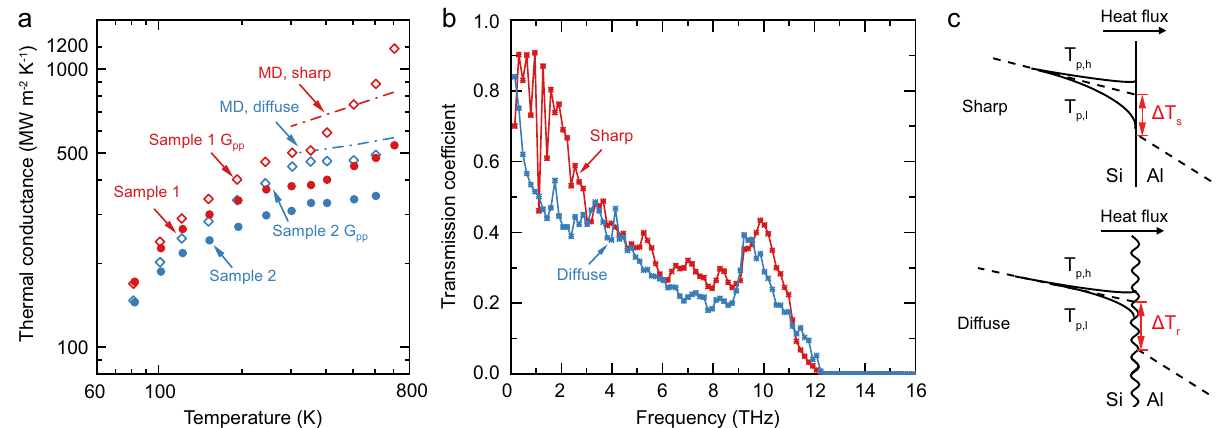
Fig. 3 | Phonon transport behavior across Al/Si interface computed by mole- cular dynamics. a Calculated thermal conductance of sharp (red dashed line) and diffuse (blue dashed line) Al/Si interfaces. b Phonon transmission coef fi cient for sharp (red) and diffuse (blue) interfaces. c Schematic of temperature distributions